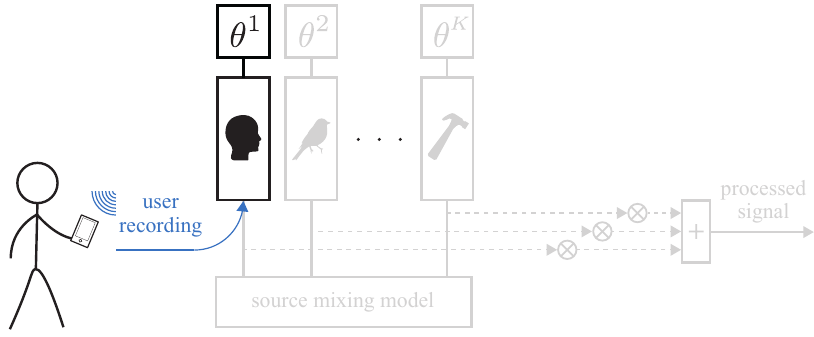
Figure 1. An overview of the source modeling stage. The user records short fragments of the observed signals and infers the corresponding model